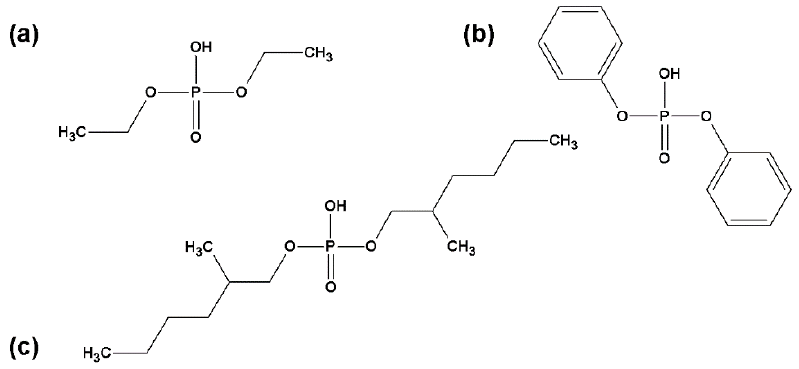
Figure 1. Structure of phosphates: ( a ) diethyl phosphate (DEPA—20 wt% of phosphorus), ( b ) diphenyl phosphate (DPPA—12.4 wt% of phosphorus), ( c ) bis(2-ethylhexyl)phosphate (DEHPA— 10.5 wt% of phosphorus).